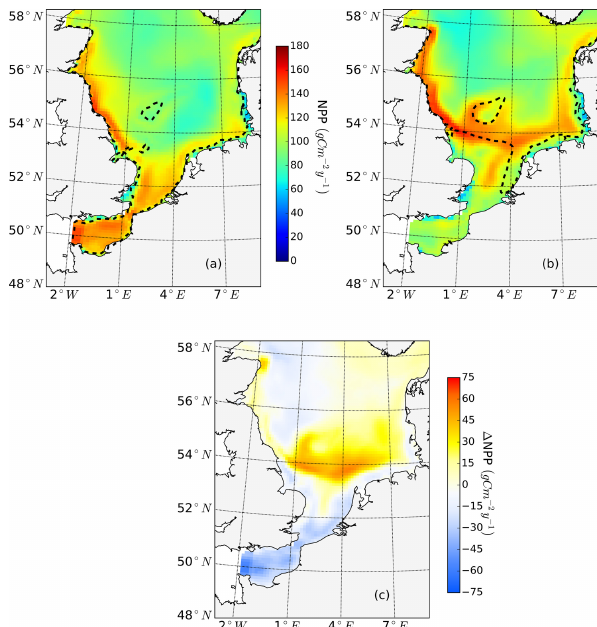
Figure 2. Mean annual net primary production for the analyzed period (1990–2015) of the non-tidal scenario (a) , tidal scenario (b) and the difference in the mean annual NPP of both scenarios (c) . Dashed lines indicate the boundary between stratified (off-shore) and unstratified (near-shore, Dogger Bank) regions. The criterion for stratification is that squared buoyancy frequency N 2 remains higher than 0.013 (s − 2 ) for more than 60d per year on